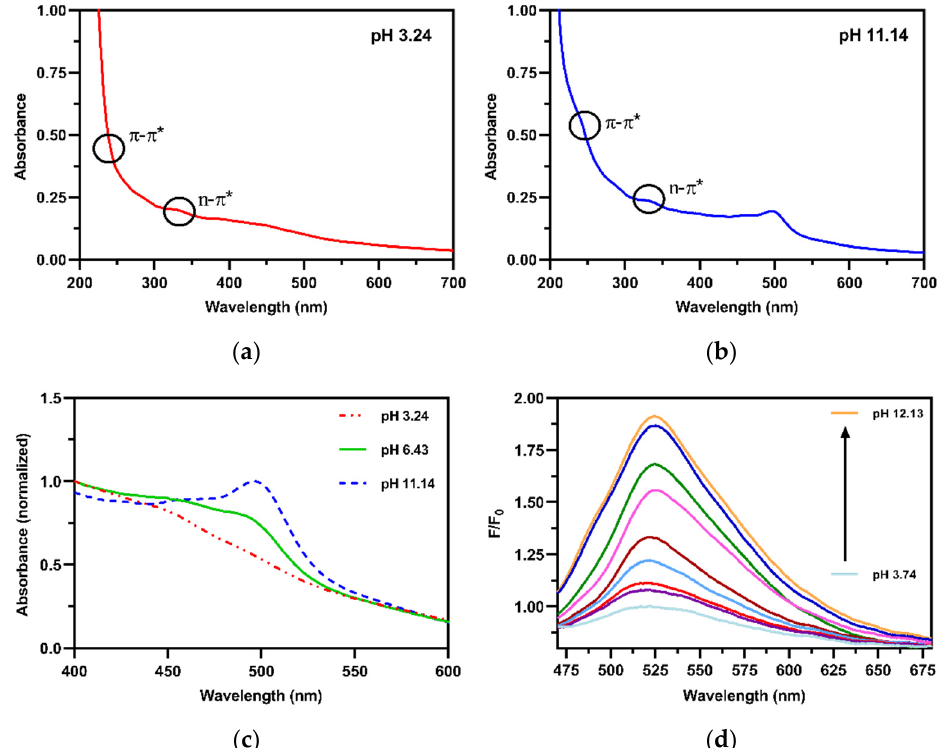
Figure 3. ( a ) UV-Vis spectra for CD F at pH 3.2. ( b ) UV-Vis spectra for CD F at pH 11.1. In both ( a ) and ( b ), the circles indicate the shoulder and peak at around 240 nm and 340 nm, respectively. ( c ) Normalized UV-Vis spectra for the CD F at pH 3.2, 6.4 and 11.1 in the wavelength range of 400–600 nm. ( d ) F/F 0 values of the emission spectra for CD F with different pH values (3.7–12.1).